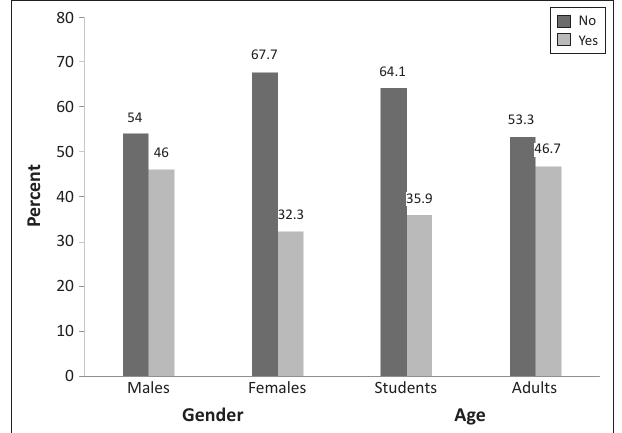
FIGURE 1: Percentage sample of current use of contraceptives by age and TABLE 2: Percentage of sample citing reasons for using contraceptives by age and gender. Reasons